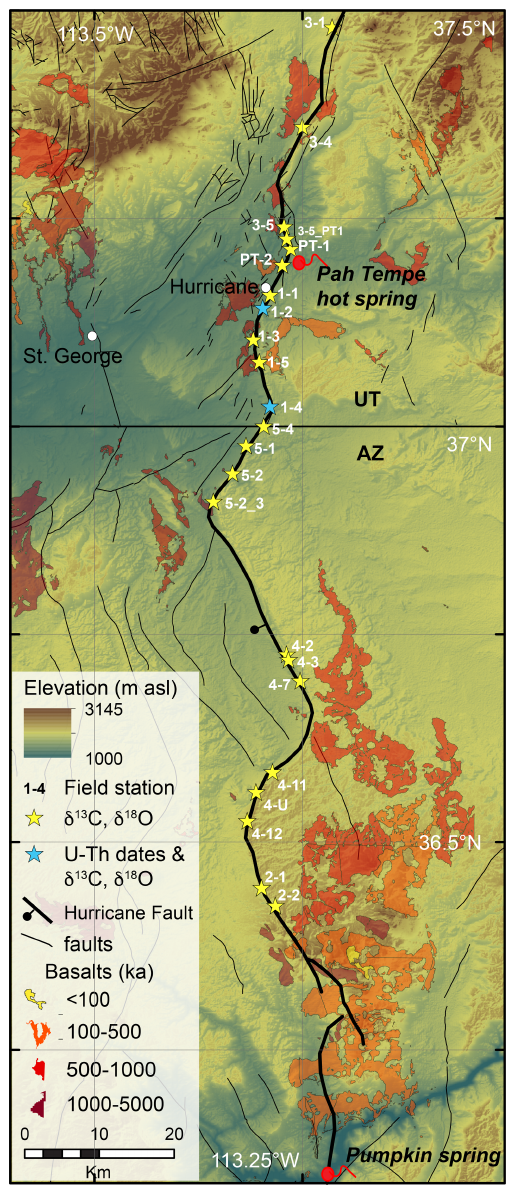
Figure 2. The Hurricane fault extent in southern Utah and north- ern Arizona, showing the 23 field stations investigated in this study. Note that C and O isotope values from calcite veins are reported for all field sites. Additionally, U–Th dates are reported from stations 1–2 and 1–4. The locations of Pah Tempe and Pumpkin springs are shown. Travertine Grotto is located south of the map extent. Geol- ogy was sourced from Billingsley and Workman (2000), Billingsley and Wellmeyer (2003), and Rowley et al. (2008). (Digital elevation, SRTM 1 Arc-Second Global https://doi.org/10.5066/F7PR7TFT, USGS EROS Archive, 2019, courtesy of the U.S. Geological Sur-